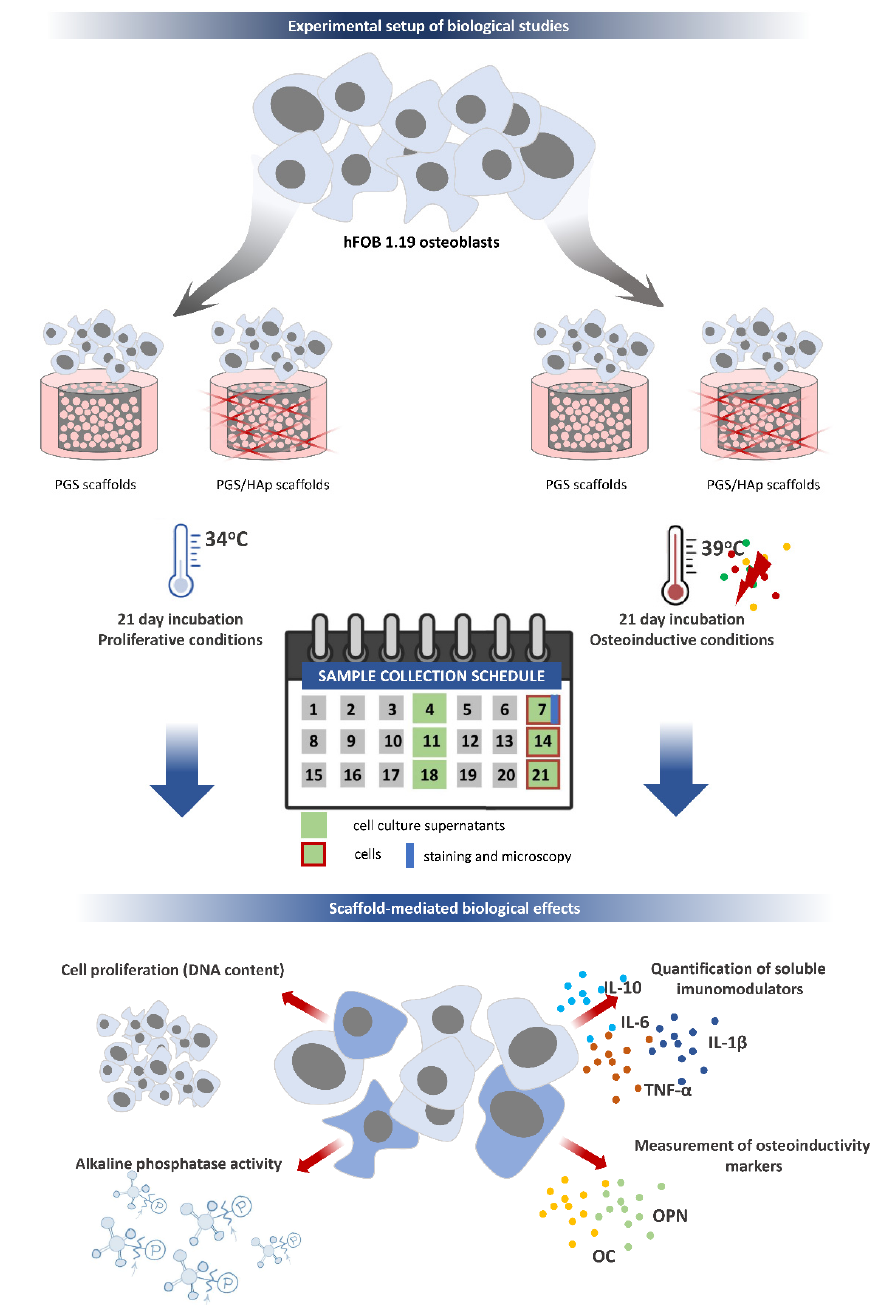
Figure 15. Experimental set up of the biological studies. Schematic representation of the experimental design for testing the scaffold-mediated biological effects toward pre and differentiated human osteoblasts hFOB1.19. The timeline for the assessment of cell proliferation, quantification of differentiation and immunomodulation markers is presented.